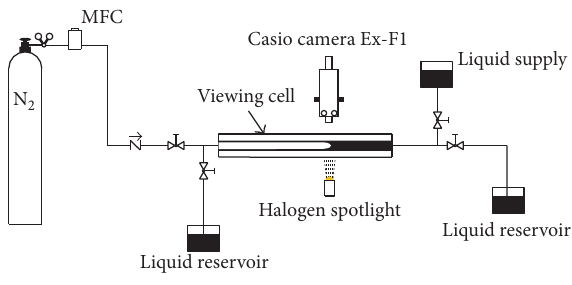
Figure 1: Experimental system.